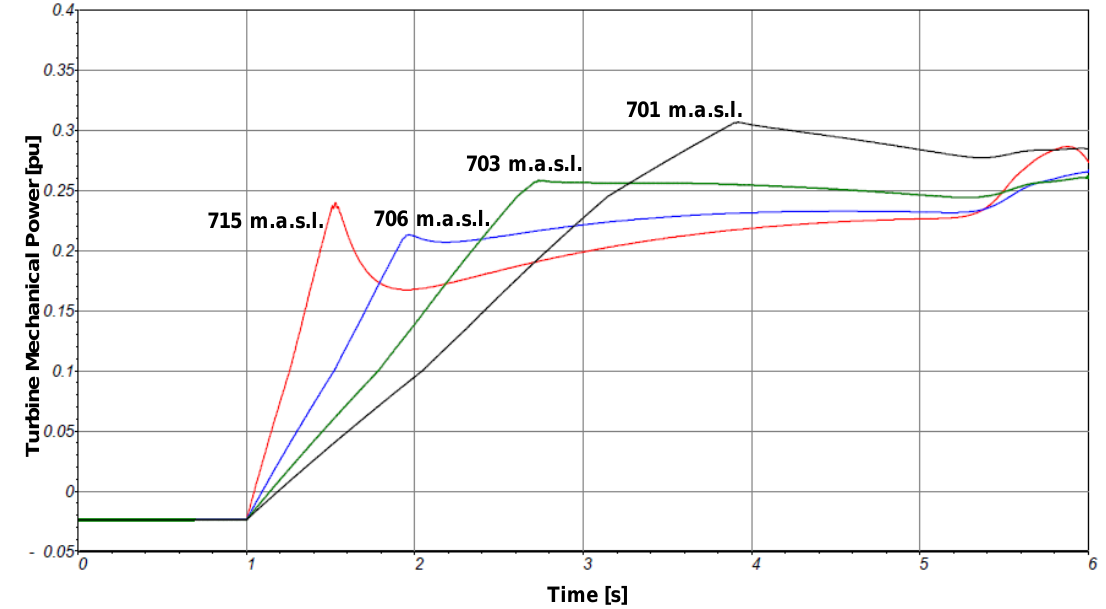
Figure 11. Turbine mechanical power after a wind generator trip for different upper reservoir levels after a 2.3 MW wind generator trip.